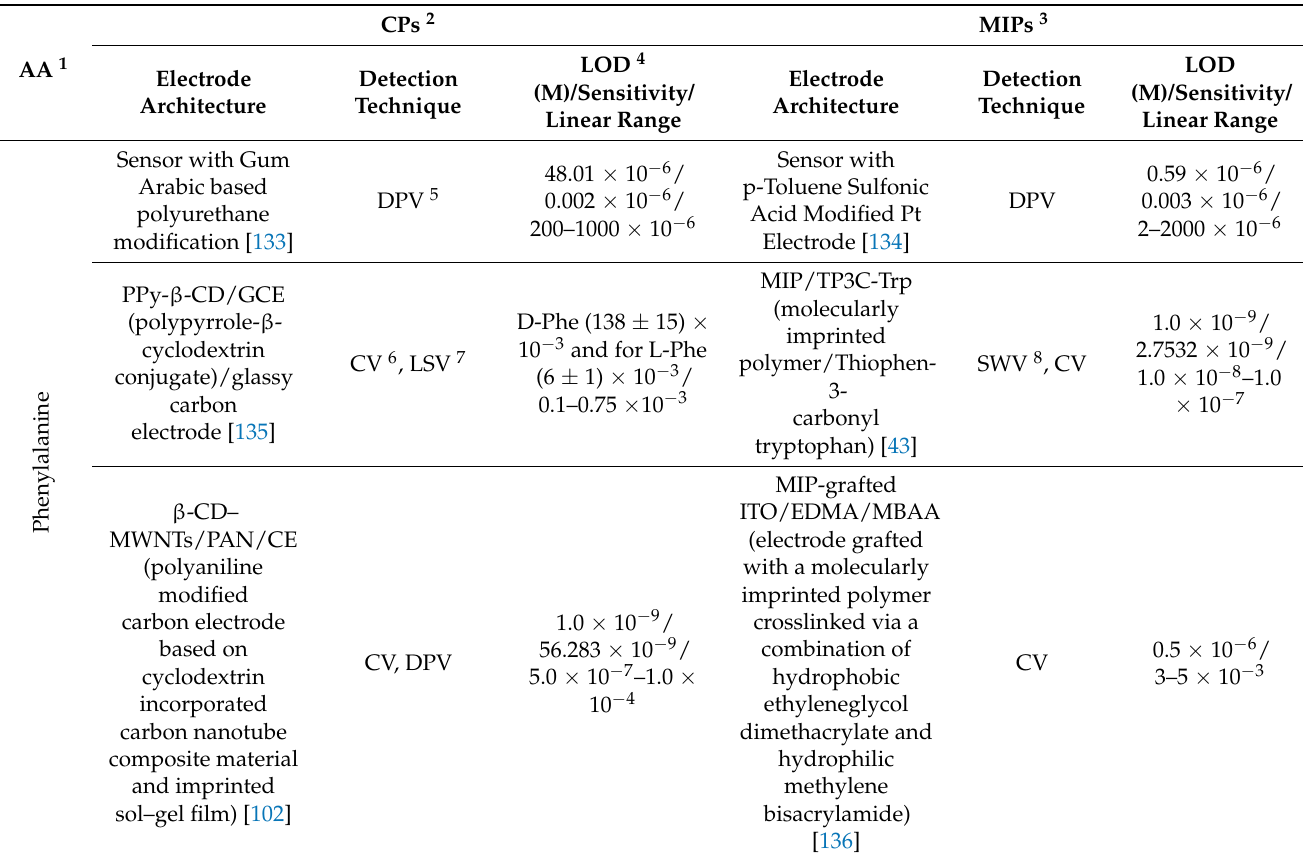
Table 7. Performances of various electrochemicals sensors based on CPs and MIPs to detect the Phe, Tyr, and Trypt AAs. A summary.